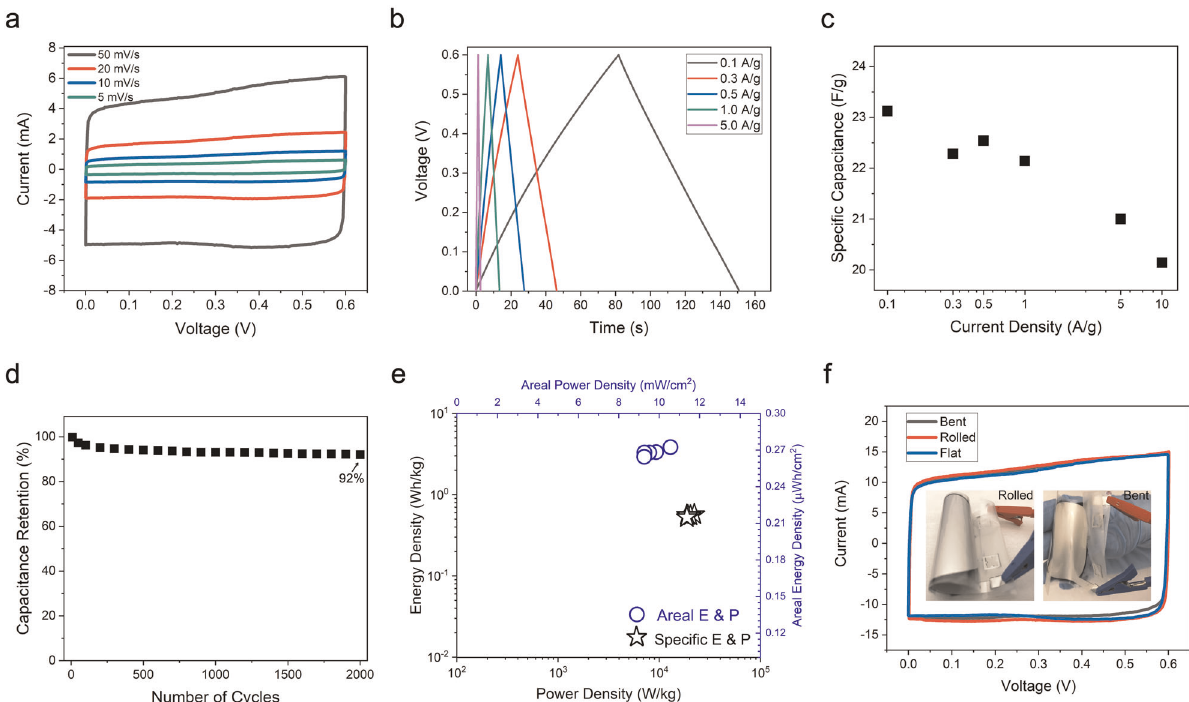
Fig. 3 Electrochemical performance of a 0.1 F printed supercapacitor. a CV curves of paper supercapacitors with different scan rates. b Galvanostatic charge-discharge curves at different current densities. c Speci fi c capacitance, ( d ) cyclic performance, ( e ) Ragone plot: speci fi c energy and power density performance of an individual supercapacitor, areal (blue circles), speci fi c energy and power density performance (stars) of an individual supercapacitor is displayed in the Ragone plot. f CV curve of the device under different mechanical conditions with the inset showing photos of the device during rolling and